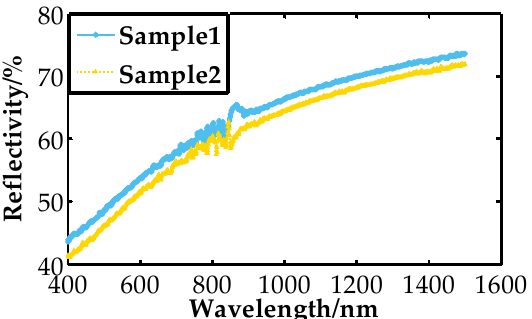
Figure 8. Reflectivity of Ni–P modified layer after different turning processes.